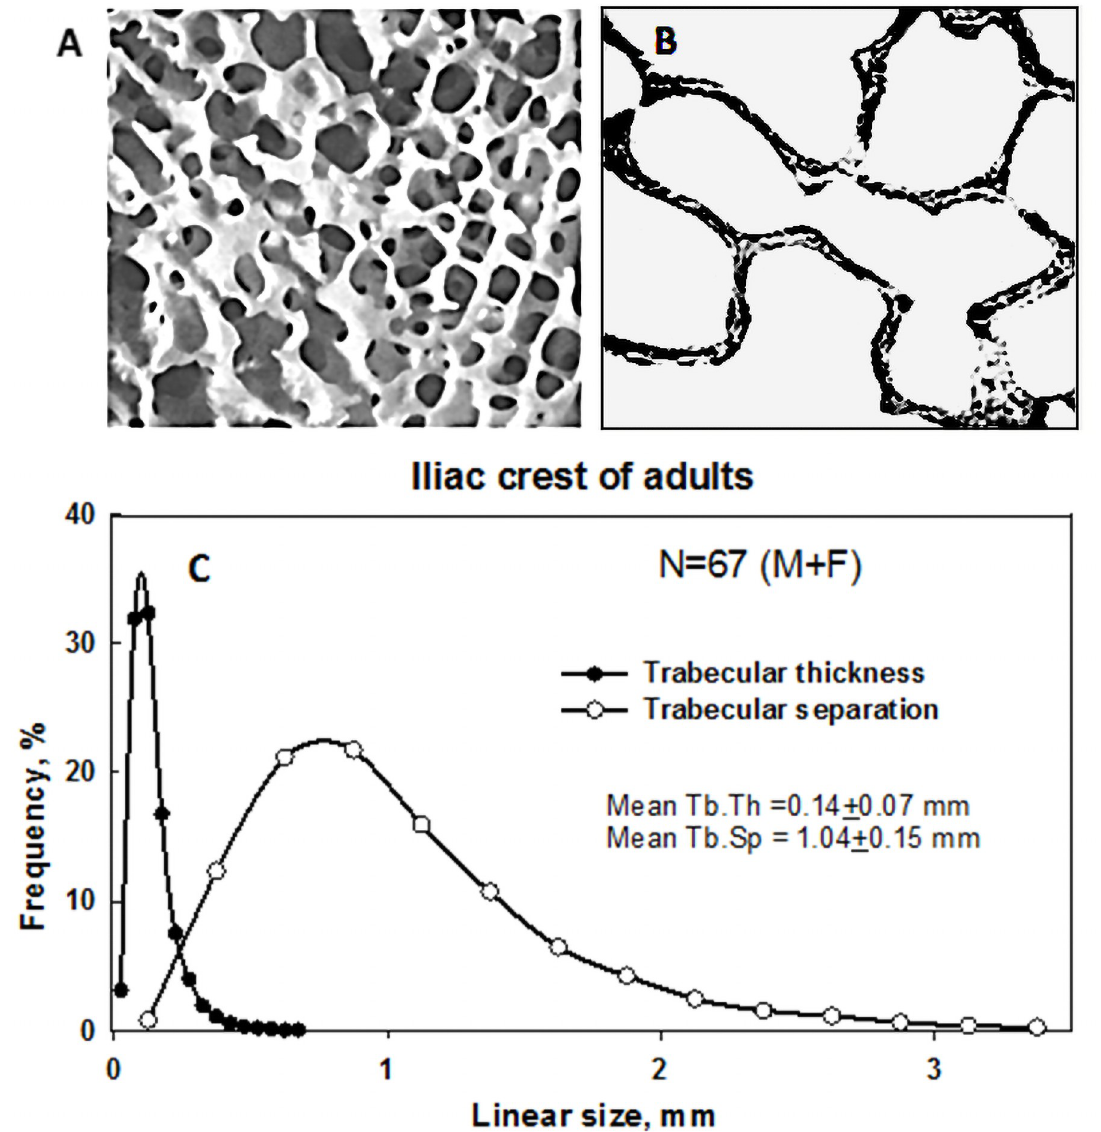
Fig 2. Spongiosa microstructure: (A) General view of spongy bone; (B) View of histological cross-section of spongy bone under a microscope: trabeculae are dark-colored and intertrabecular cavities are light-colored; (C) Statistical distributions of trabecular thickness and trabecular separation measured on a collection of histological slides prepared from iliac crest specimens based on data published in [28].